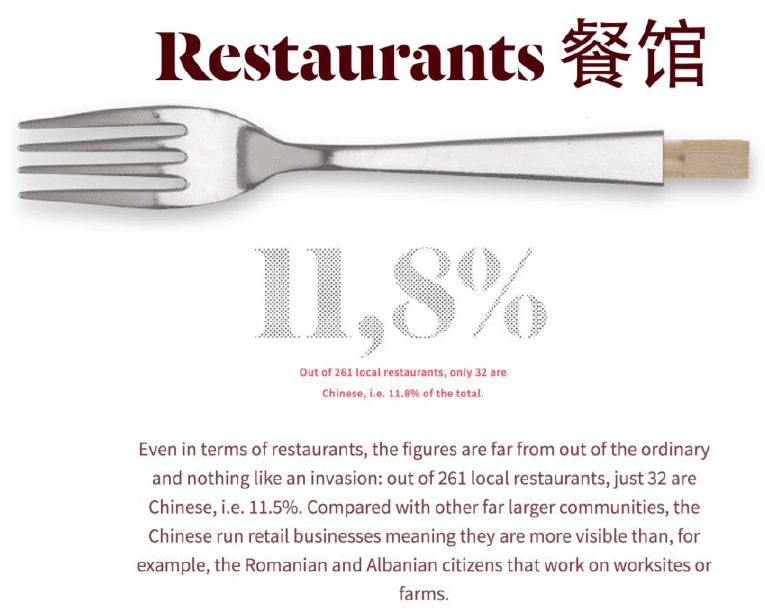
Figure 2. Animated data visualization from the website People’s republic of Bolzano.